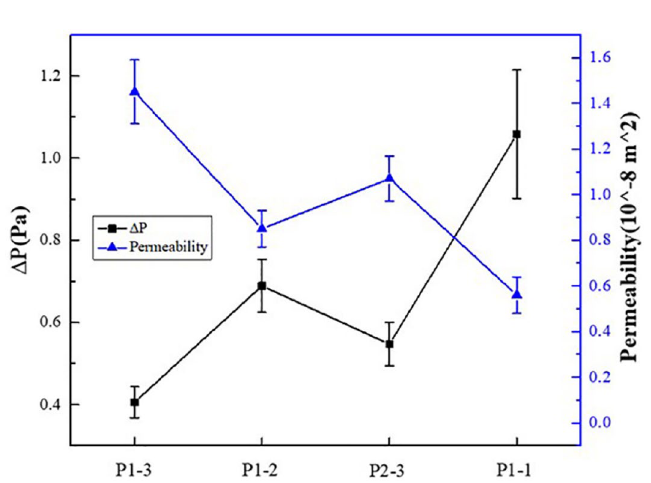
Figure 8. Four groups of scaffolds pressure drop cloud: ( a ) P1-3 pressure drop cloud; ( b ) P1-2 pressure drop cloud; ( c ) P2-3 pressure drop cloud; ( d ) P1-1 pressure drop cloud.